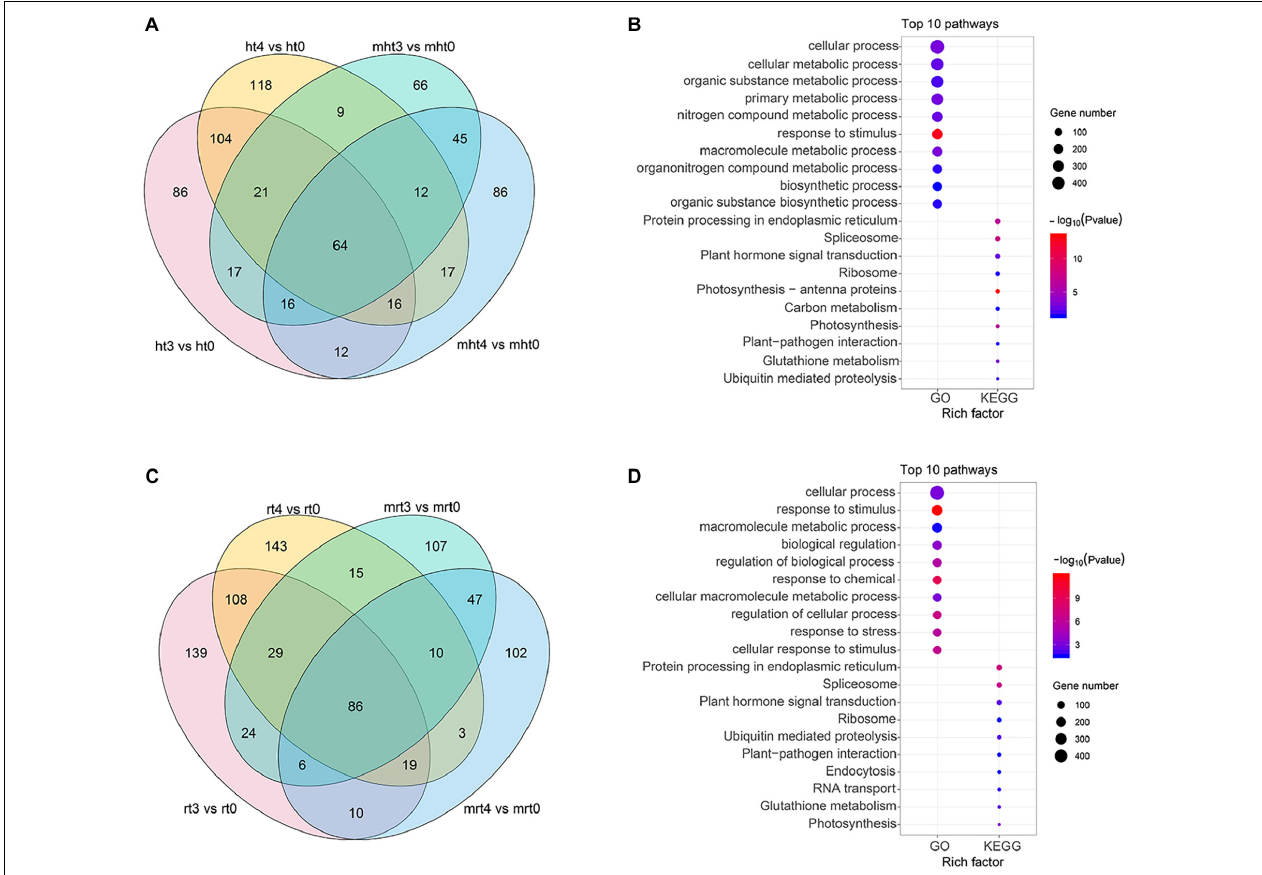
FIGURE 4 | Identification and characterization of DELs. (A,C) Venn gram showing the distribution of DELs in WT and RB tissues, respectively. (B,D) GO and KEGG enrichment analysis were performed, and the top 10 GO terms and KEGG pathways are shown. The circle size represents the gene number. Blue to red represents the low to high P